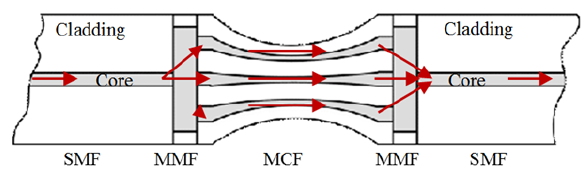
Fig. 1 Multi-core micro/nano fiber interferometric sensor structure.